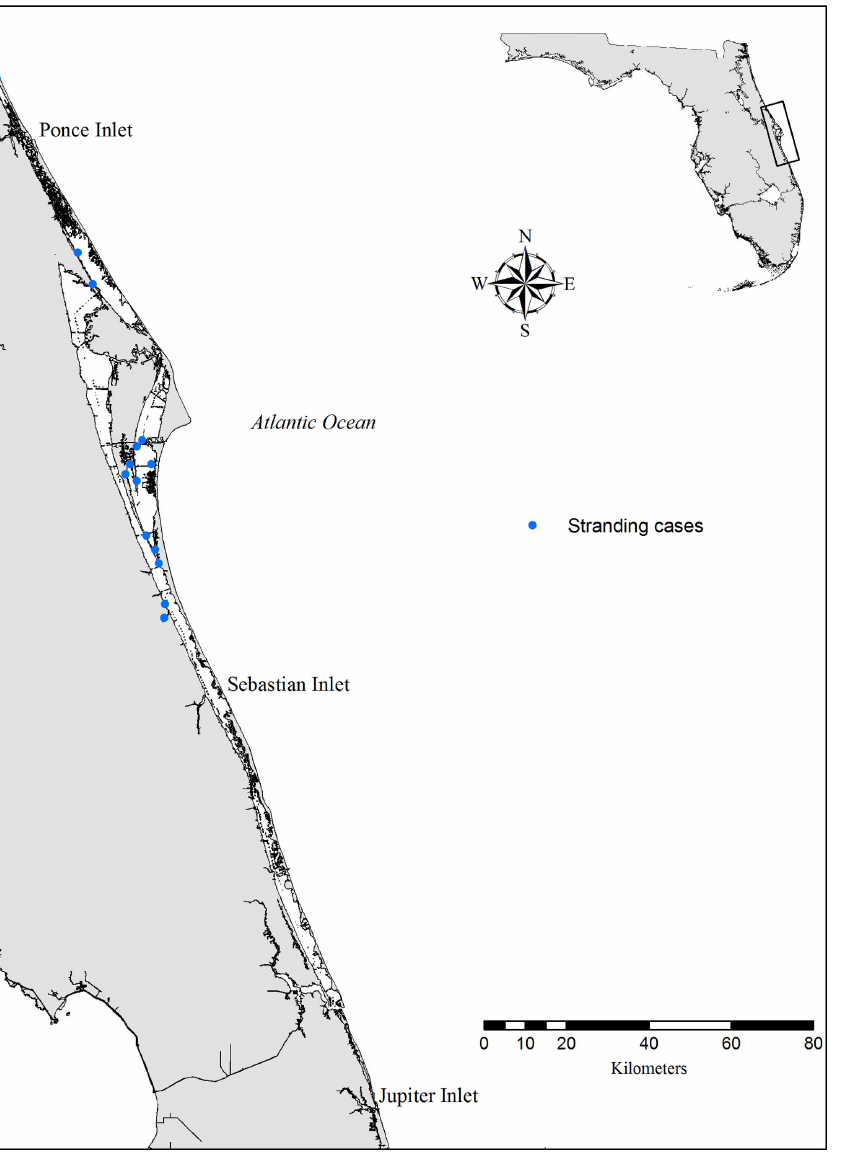
Figure 1. Map of study area. Study area on the central east coast of Florida. The Indian River Lagoon is comprised of three interconnected water bodies separated from the Atlantic Ocean by barrier islands. Records of stranded dolphins that died of asphyxiation are symbolized as blue